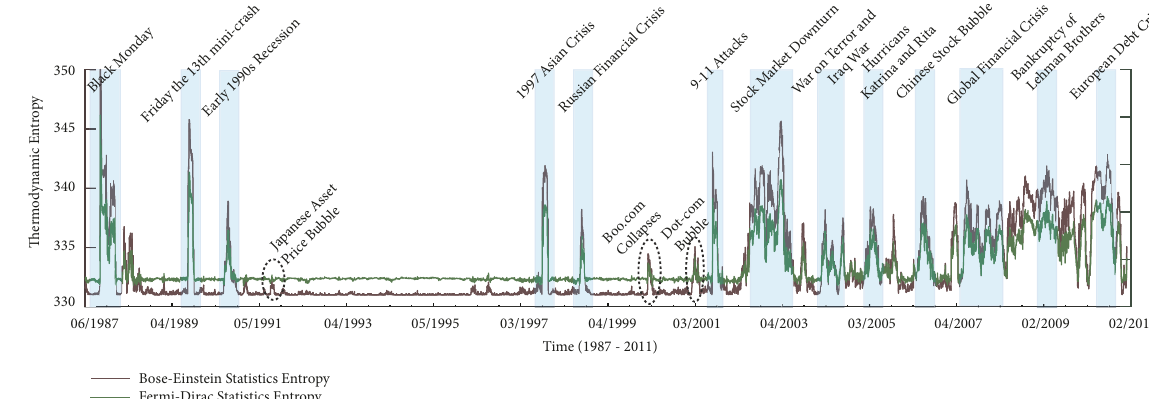
Figure 2: Entropy in NYSE (1987-2011) derived from Bose-Einstein and Fermi-Dirac statistics. Critical financial events, i.e., Black Monday, Friday the 13th mini-crash, Early 1990s Recession, 1997 Asian Crisis, 9.11 Attacks, Downturn of 2002-2003, 2007 Financial Crisis, the Bankruptcy of Lehman Brothers, the European Debt Crisis, etc. It is efficient to use thermodynamic entropy to identify critical events in NYSE.